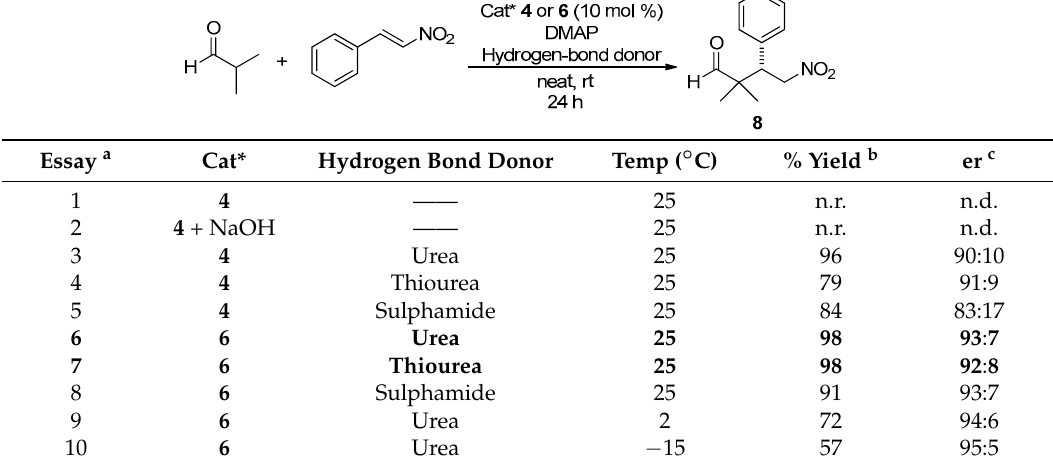
Table 8. Michael addition reaction of aldehydes to different substrates.